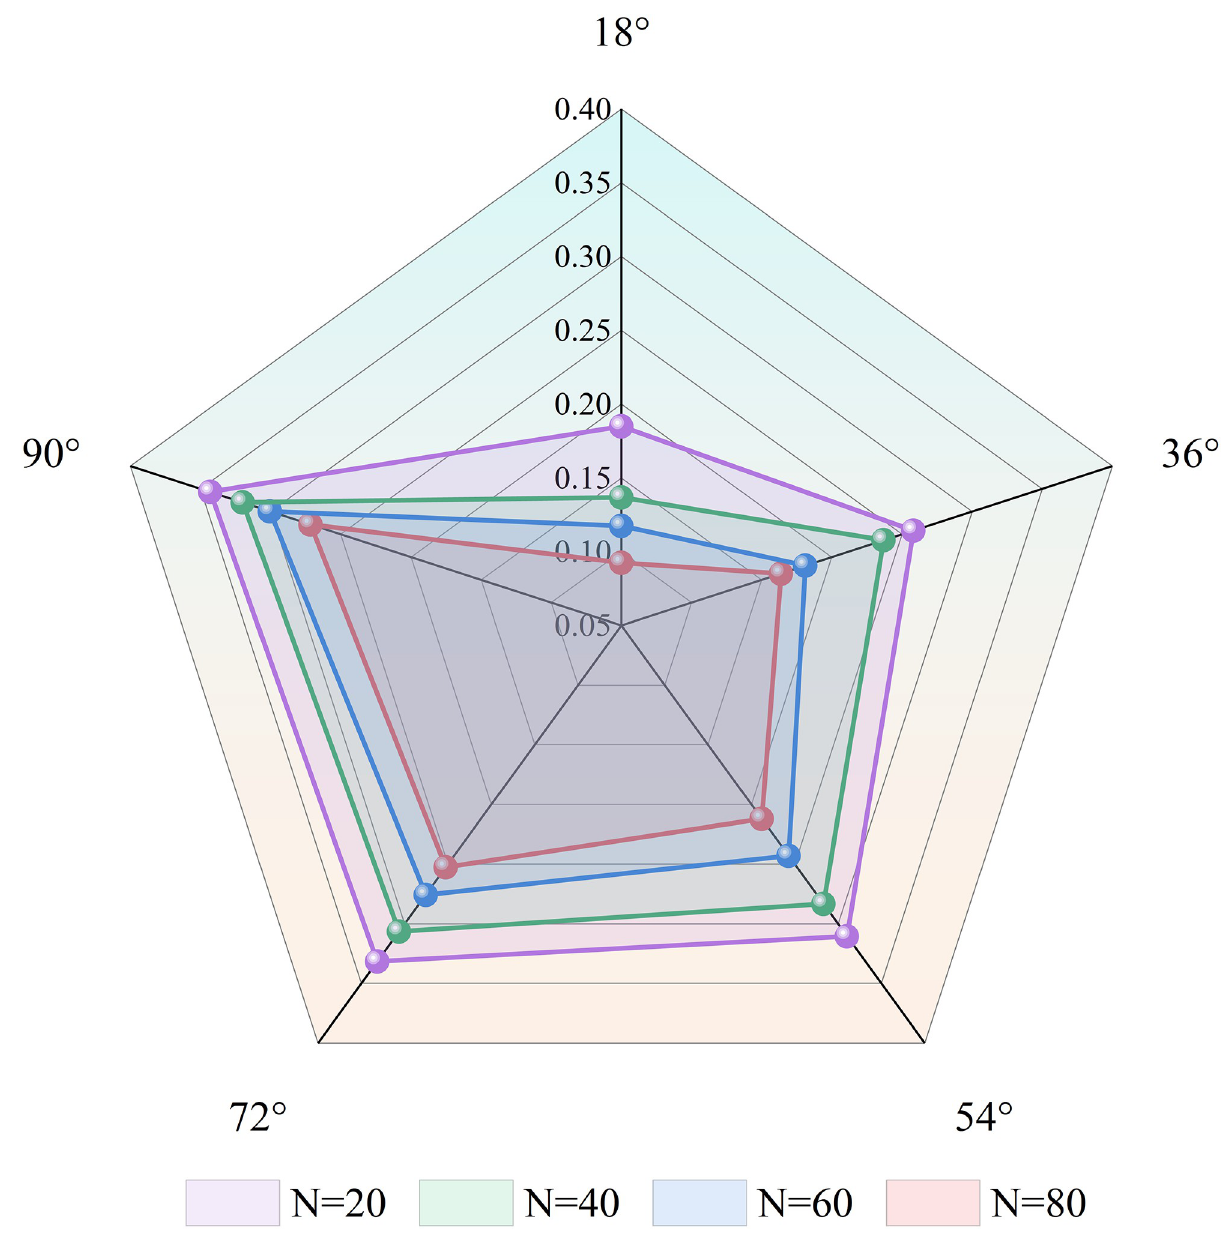
Fig 9. The variation law of the stress intensity factor at the crack